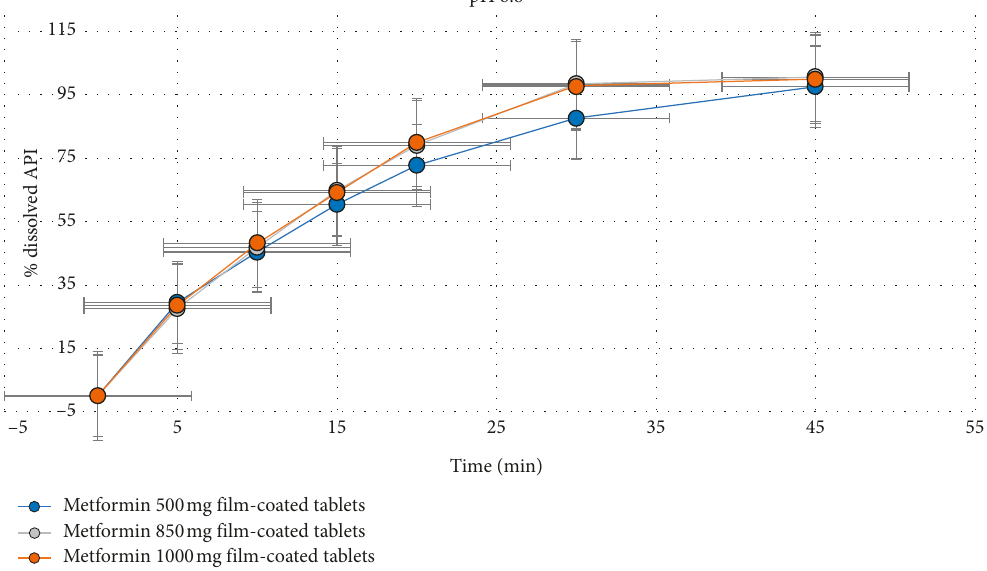
Figure 4: Dissolution profiles of different strengths of metformin film-coated